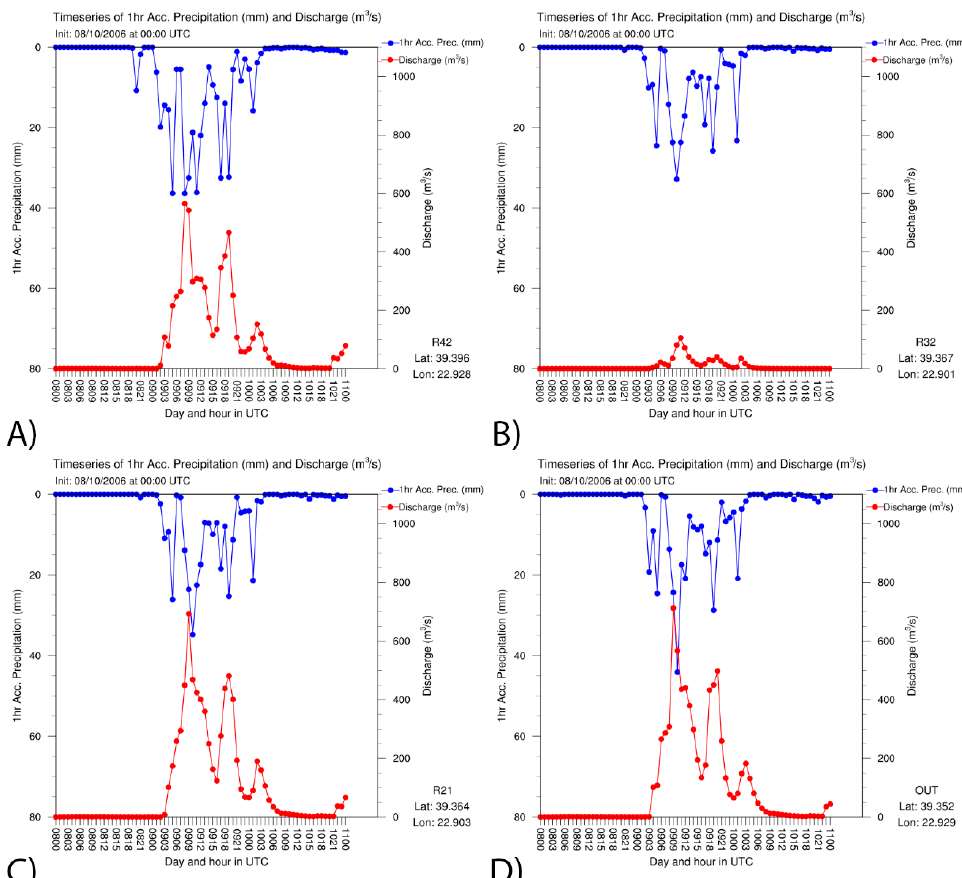
Figure 8. Hydrologic Response of Xerias Watershed for the extreme storm event of 9 October 2006 at the locations ( A ) R42 (Upper Xerias sub-watershed), ( B ) R32 (Seskouliotis and Kakaviotis sub-watershed), ( C ) R21, and ( D ) OUT (Xerias Watershed outlet). Discharge (m 3 s − 1 ) simulated by the WRF-Hydro model and 1-h accumulated precipitation (mm) simulated by the WRF-ARW model are depicted with red and blue colours, respectively.